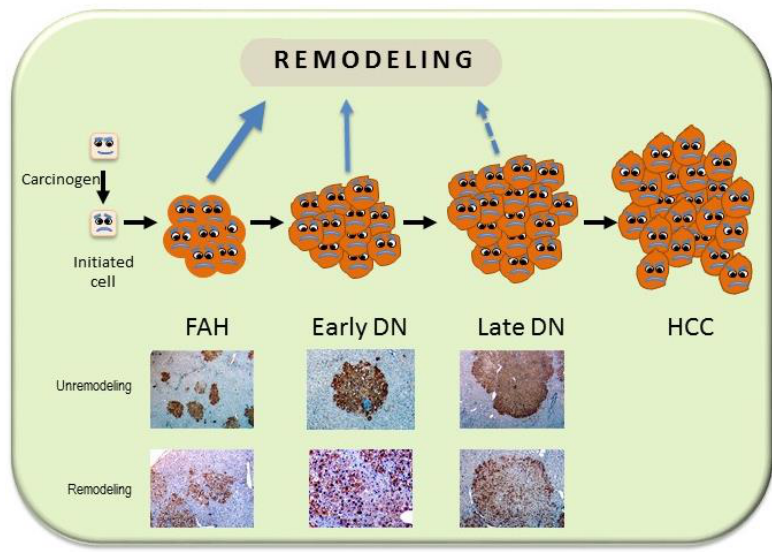
Figure 3. Schematic representation of multistage hepatocarcinogenesis. After hepatocarcinogenesis initiation, the initiated cells undergo a selective expansion that leads to the development of foci of altered hepatocytes (FAH), early dysplastic nodules (DN), late DN, and hepatocellular carcinomas (HCC). Severely damaged cells may undergo apoptosis (not shown), whereas weak DNA damage followed by DNA repair may consent initiated cells to re-differentiate (remodeling; reverse arrows). Remodeling progressively decreases and ceases in cancer cells.